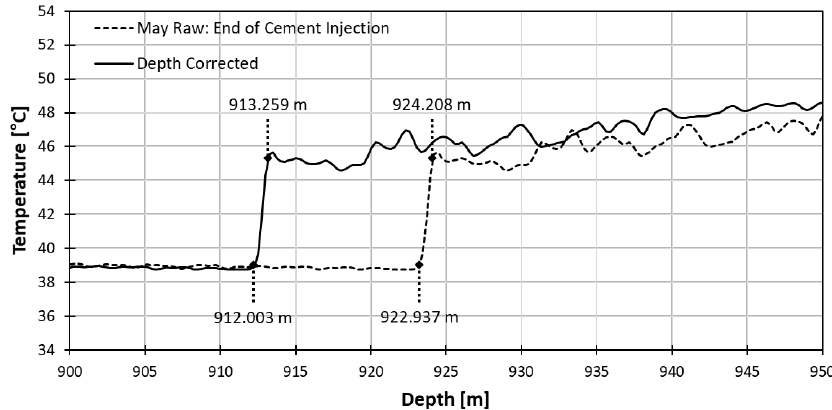
Figure 5. Temperature profiles before and after applying depth correction to data at the end of cement injection in May.